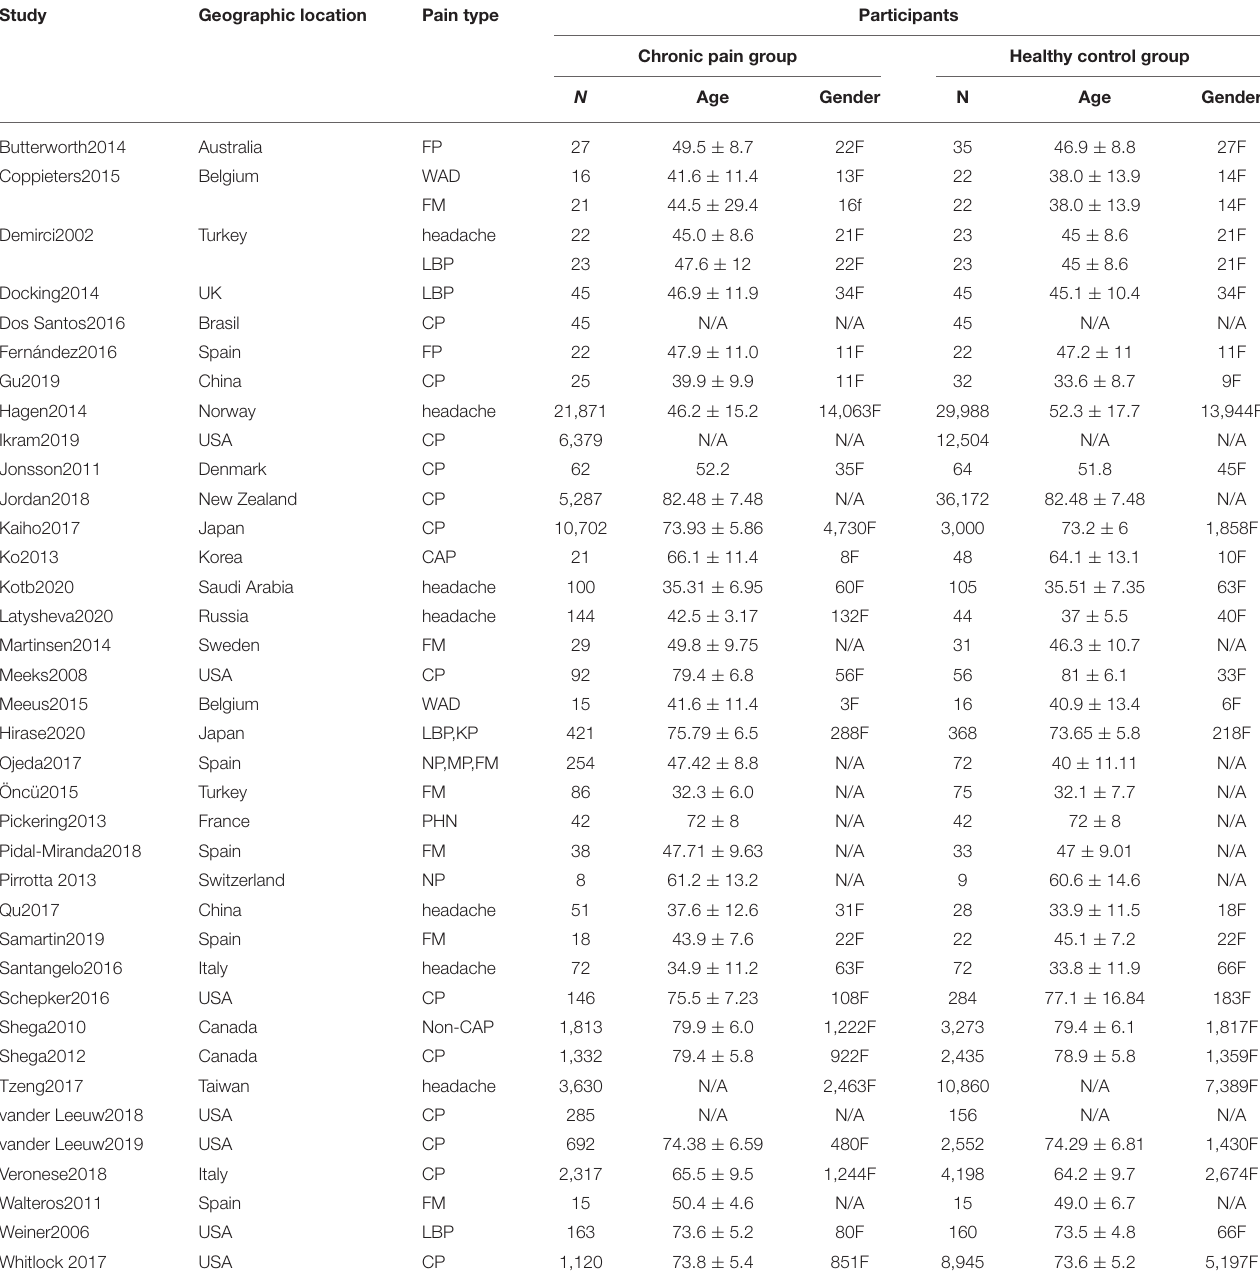
TABLE 1 | Characteristics of the included